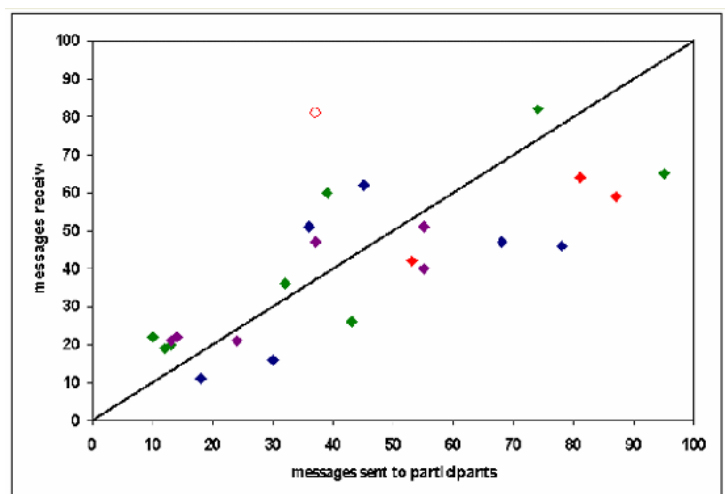
Figure 9. Rate of interaction between individuals in the small